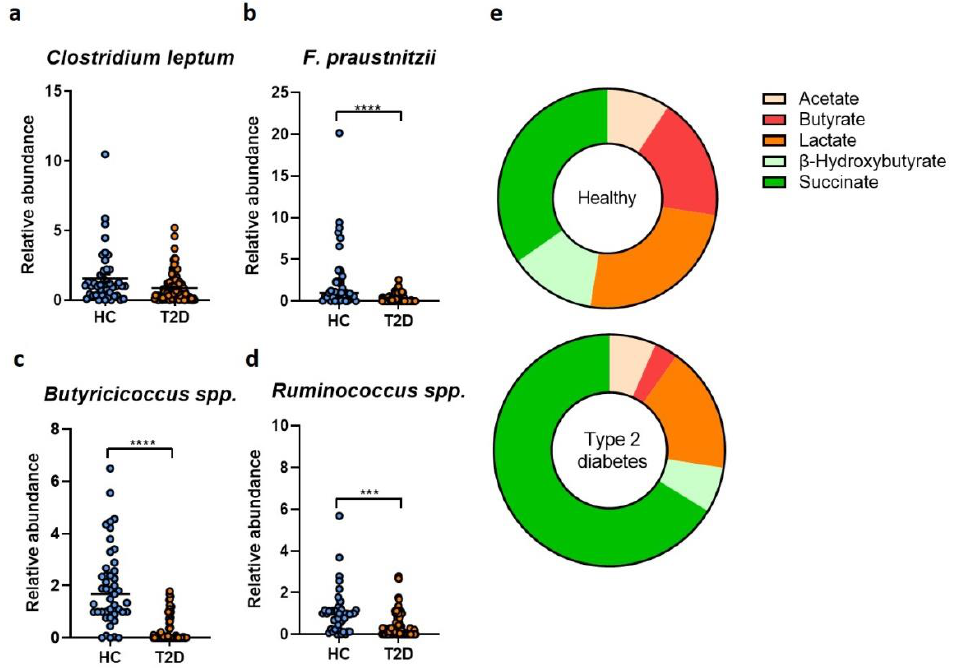
Figure 3. Microbiota and metabolite analysis in T2D patients ( n = 105) versus healthy controls ( n = 45). The relative abundance of the Clostridium leptum ( a ), F. prausnitzii ( b ), Butyricicoccus ( c ), Ruminococcus ( d ) in fecal samples harvested from healthy individuals and T2D patients; ( e ) metabolites quantification in fecal samples harvested from healthy individuals and T2D patients ***, p < 0.001, **** p < 0.0001.